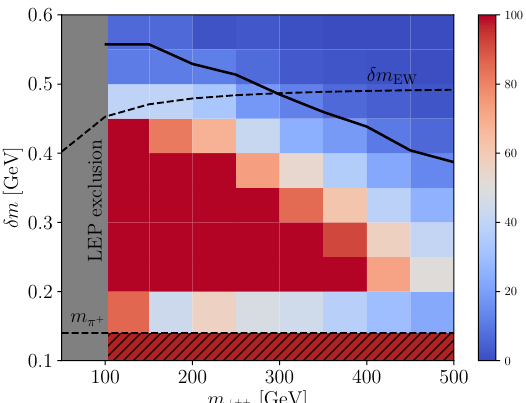
Figure 2 . Exclusions from the CMS displaced electron-muon pair search [22] in the m ++ - (cid:14)m plane. The dashed line corresponds to electroweak mass splitting which plateaus at 0.49 GeV. The coloured heat-map shows the value of the test statistic (de(cid:12)ned in appendix A), which is the Q log likelihood ratio of the signal and background. Region under solid black line (with > 5 : 99) Q is excluded. The bottom hatched red area refers to limits from heavy stable charged track search whereas the grey vertical area refers to the LEP excluded region up to m ++ = 103 GeV [24,